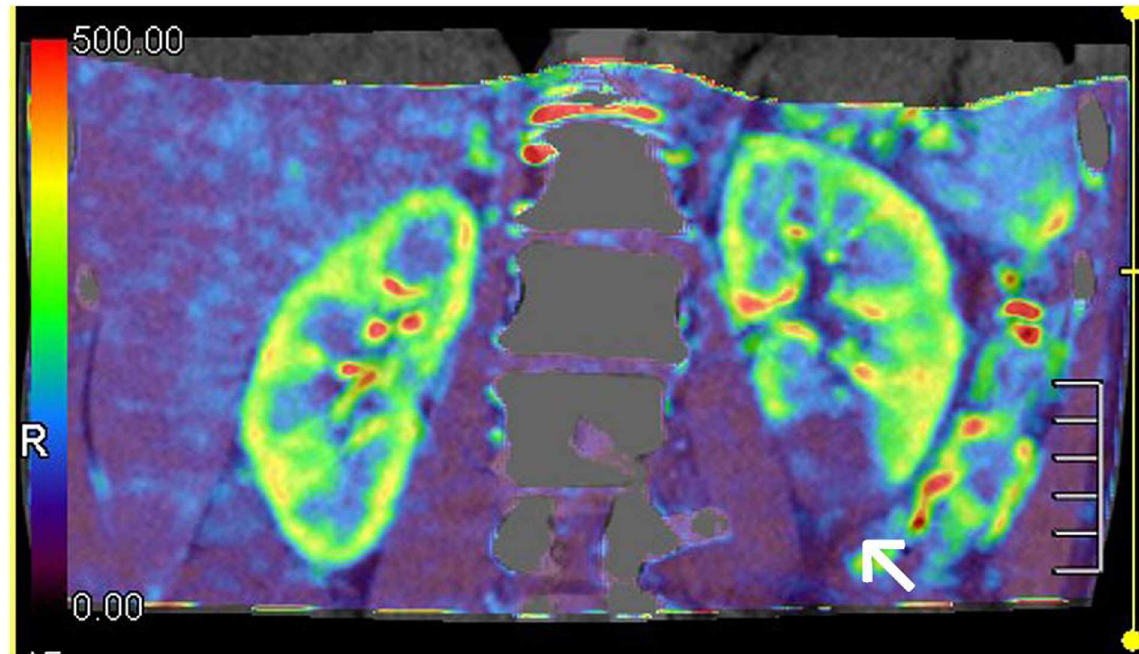
Fig 6. Blood flow (BF) color maps of bilateral kidneys. White arrow indicate the partiallydecreasingBF.